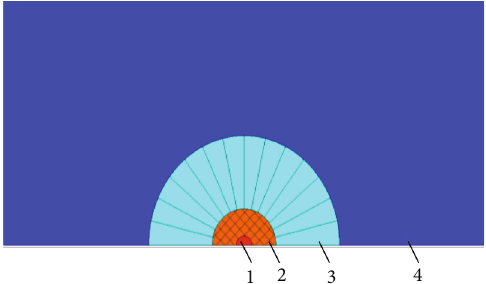
Figure 1: Zone division of rock damage. 1-cavity zone; 2-crusing zone; 3-radical crack zone; 4 elastic